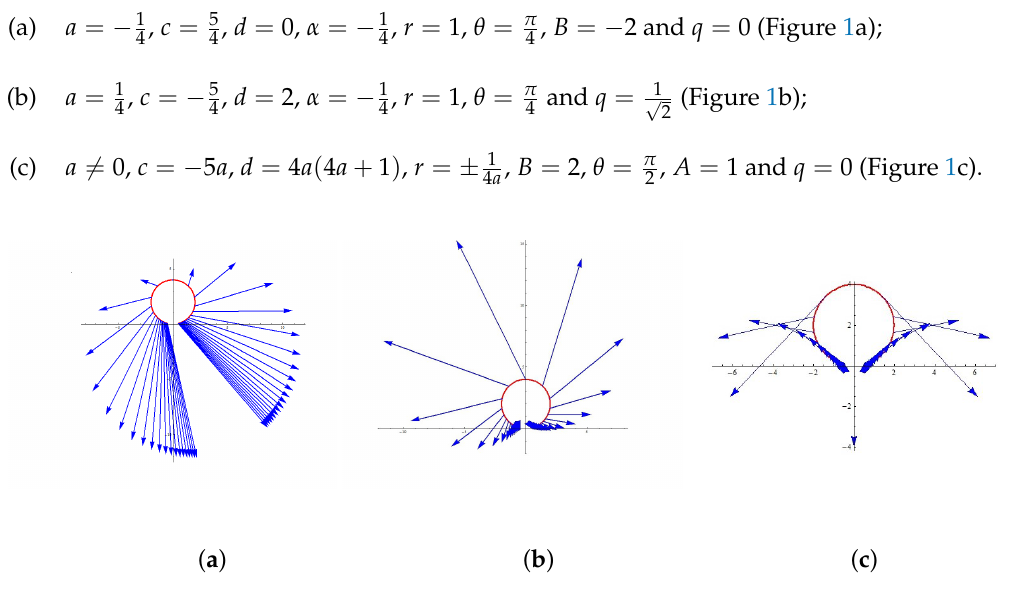
Figure 1. Examples on H 2 ( − 4 ) . Curves ( a – c ) are slant